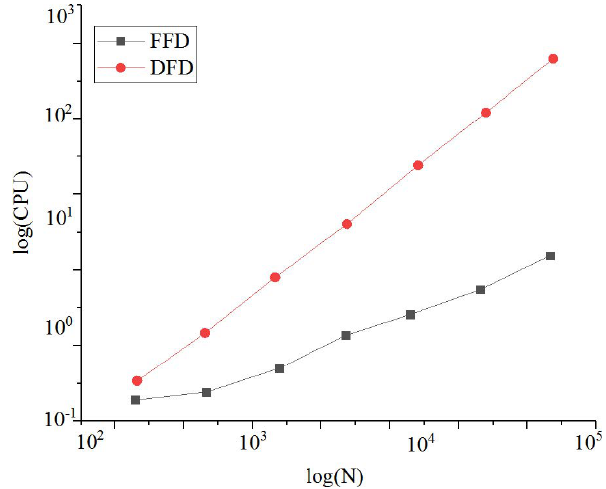
Fig. 1 Relationship between CPU time consumed by DFD and FFD and time step in log-log